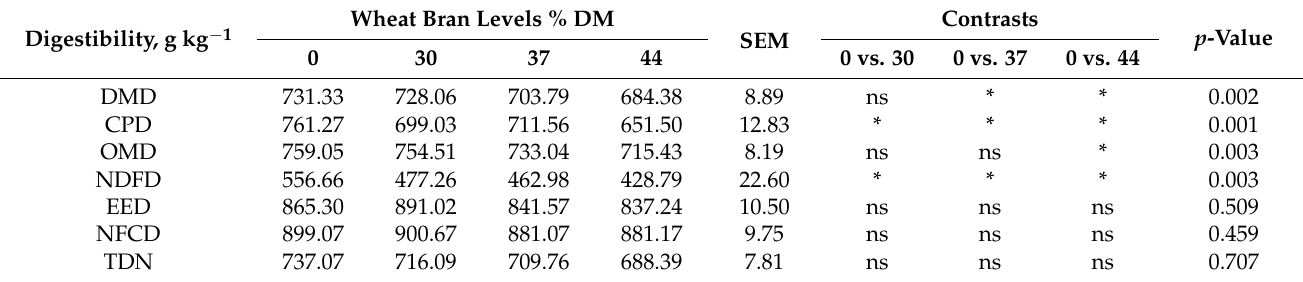
Table 4. In situ coefficient of digestibility of diets nutrients of lambs fed diets with cactus pear as the only forage source and levels of wheat